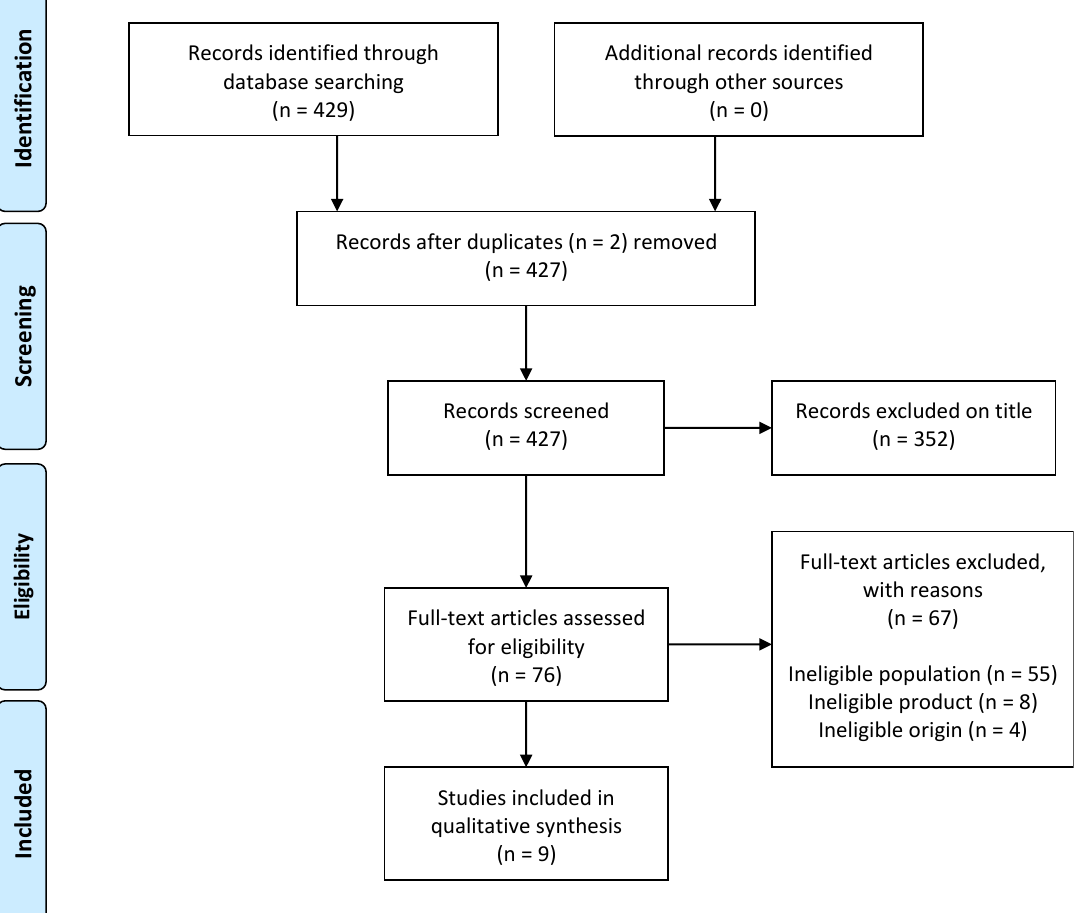
Figure 1. Preferred Reporting Items for Systematic Reviews and Meta-Analyses (PRISMA) flow diagram [23].